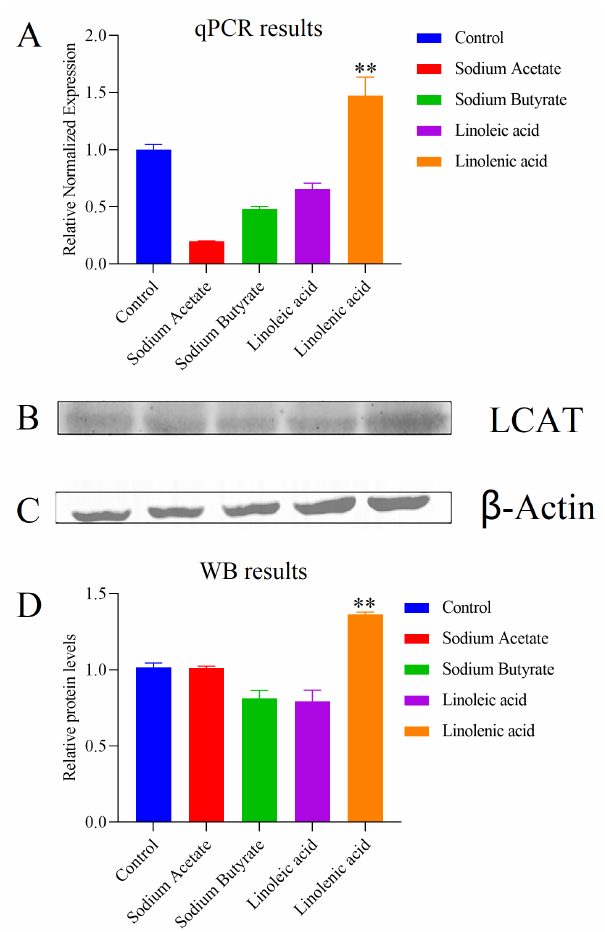
Figure 8. qPCR and WB results based on targeted metabonomics: ( A ) Effects on mRNA levels of LCAT in H460 cells treated with sodium acetate, sodium butyrate, linoleic acid, and linolenic acid for 24 h, n = 3. ( B ) WB results of LCAT; from left to right are the control group, sodium acetate group, sodium butyrate group, linoleic acid group, and linolenic acid group. ( C ) WB results of β -Actin; 17rom left to right are the control group, sodium acetate group, sodium butyrate group, linoleic acid group, and linolenic acid group. ( D ) Effects on protein content in H460 cells treated with sodium acetate, sodium butyrate, linoleic acid, and linolenic acid for 24 h; n = 6; **: p value < 0.01.